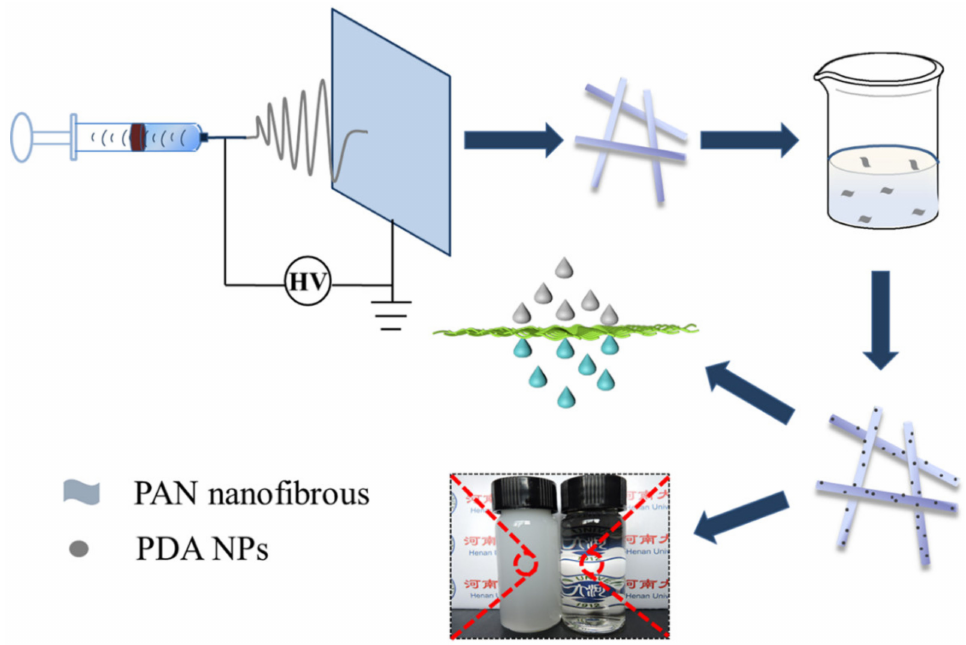
Figure 1. Schematic diagram of preparation process and oil-in-water emulsion separation perfor- mance of PDA@PAN electrospinning nanofibrous